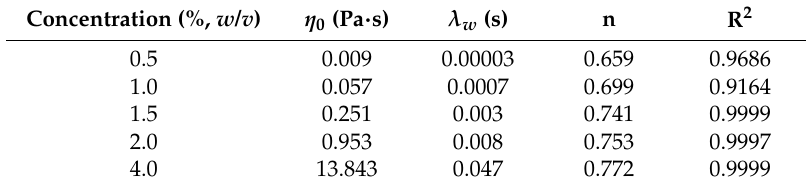
Table 1. Fitting parameters of Williamson model for TSP solutions at a series of